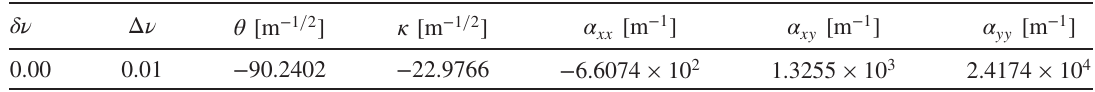
TABLE I. Parameters for the Double